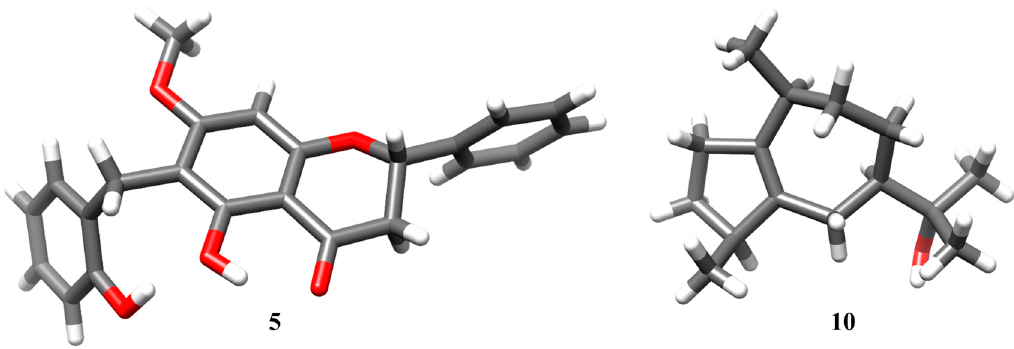
Figure 3. X-ray crystal structure of 7-methoxyisochamanetin ( 5 ) and guaiol ( 10 ).